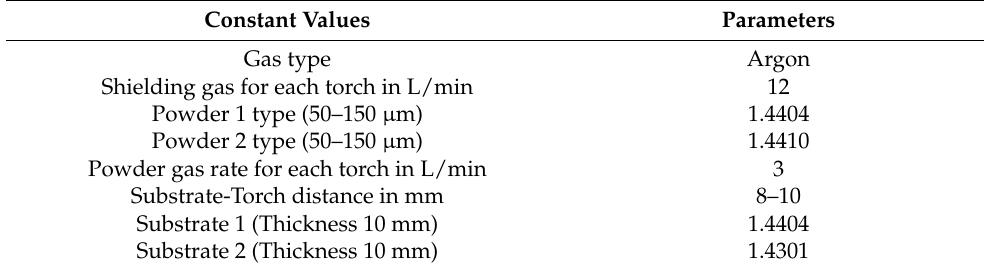
Table 2. Constant values of the process parameters.